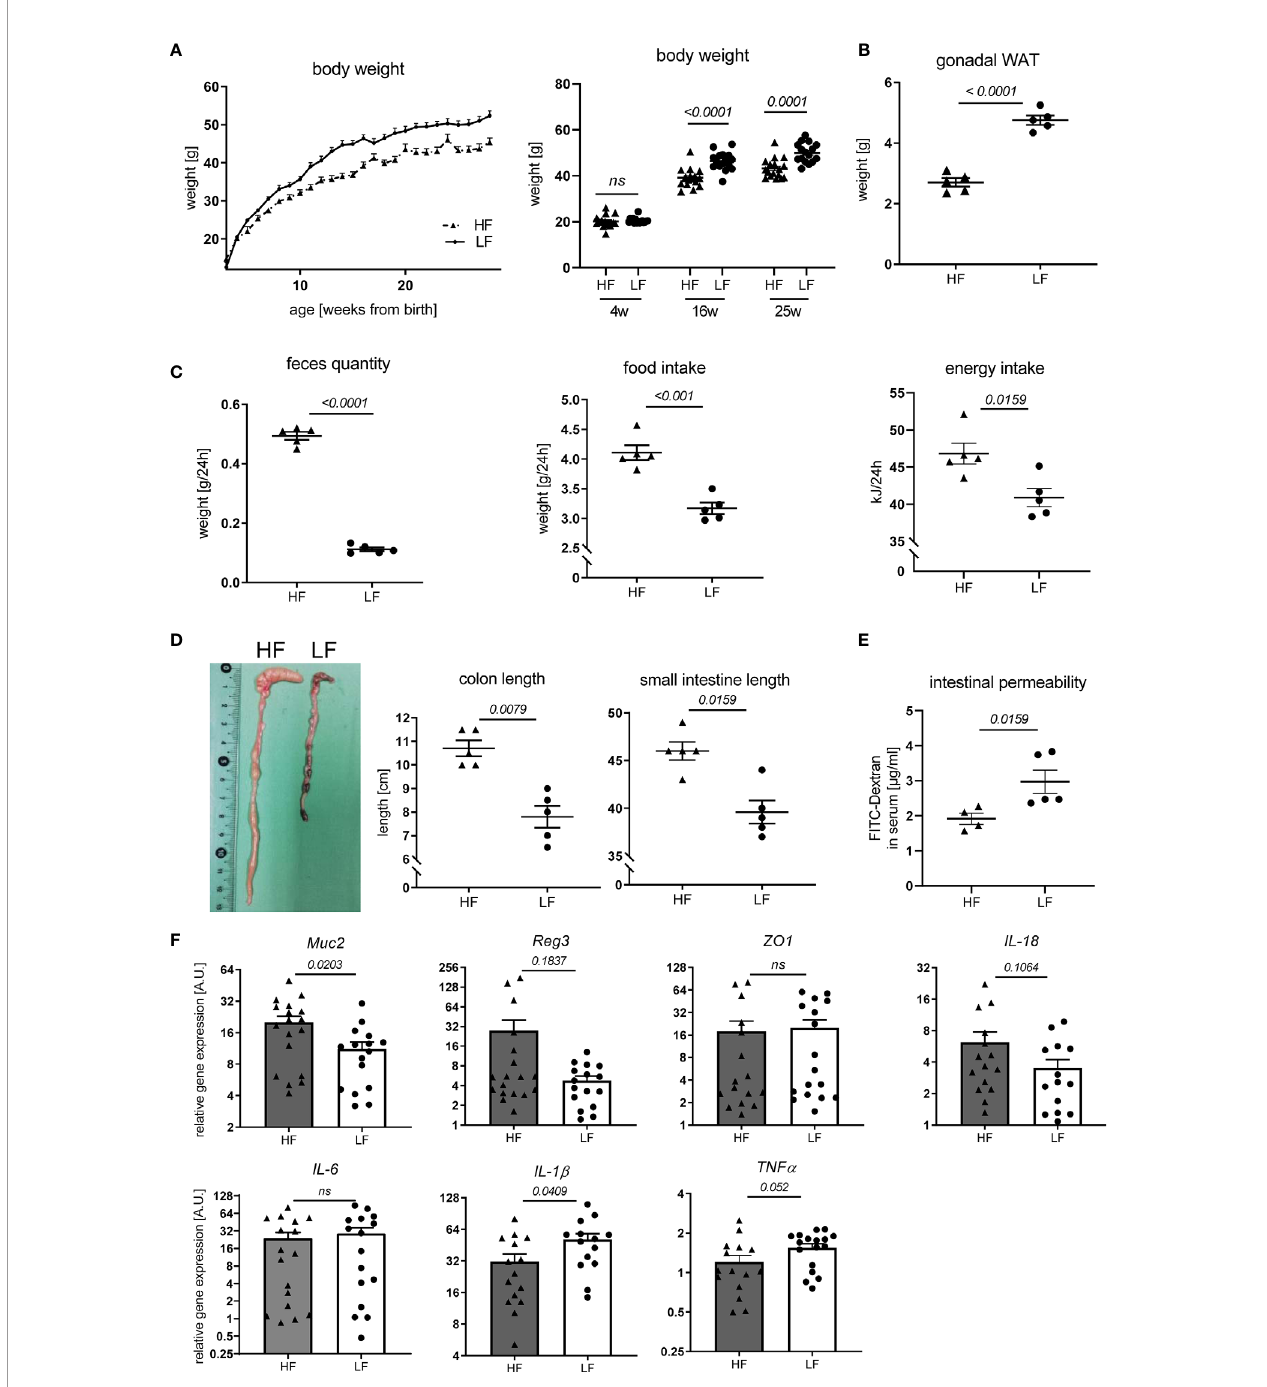
FIGURE 3 | Impact of dietary fi ber on weight regulation and intestinal homeostasis. Lupus-prone NZB/WF1 mice were fed a HF- or LF-diet. (A) Body weights are shown from 3 – 28 weeks of age (left) and at de fi ned time points (right) (n HF = 18 mice, n LF = 16 mice; representative of two independent experiments). (B – D) Weight of gonadal white adipose tissue (WAT) (B) , feces quantity, food and energy intake per day (C) as well as lengths of small intestine and colon (D) were determined at 28 w (n HF/LF = 5 mice, representative of at least two independent experiments). (E) Quanti fi cation of intestinal permeability with FITC- Dextran applied by oral gavage in 28 w old animals (n HF = 4 mice, n LF = 5 mice, representative for two independent experiments). (F) Relative mRNA expression of molecules associated with gut barrier function and in fl ammation in colon of 28 w old animals (n HF = 15 – 18 mice, n LF = 15 – 17 mice). Results are expressed as scatter blots or trend line with mean ± SEM; each data point represents an individual mouse; p < 0.05 was considered signi fi cant, p > 0.2 is indicated as ns, not signi fi cant